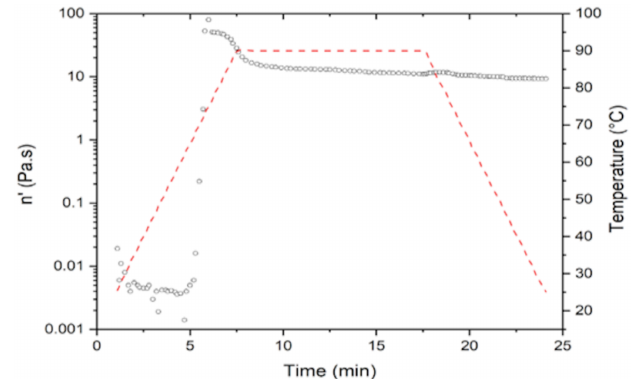
Figure 2. Viscoamilograms of native rice